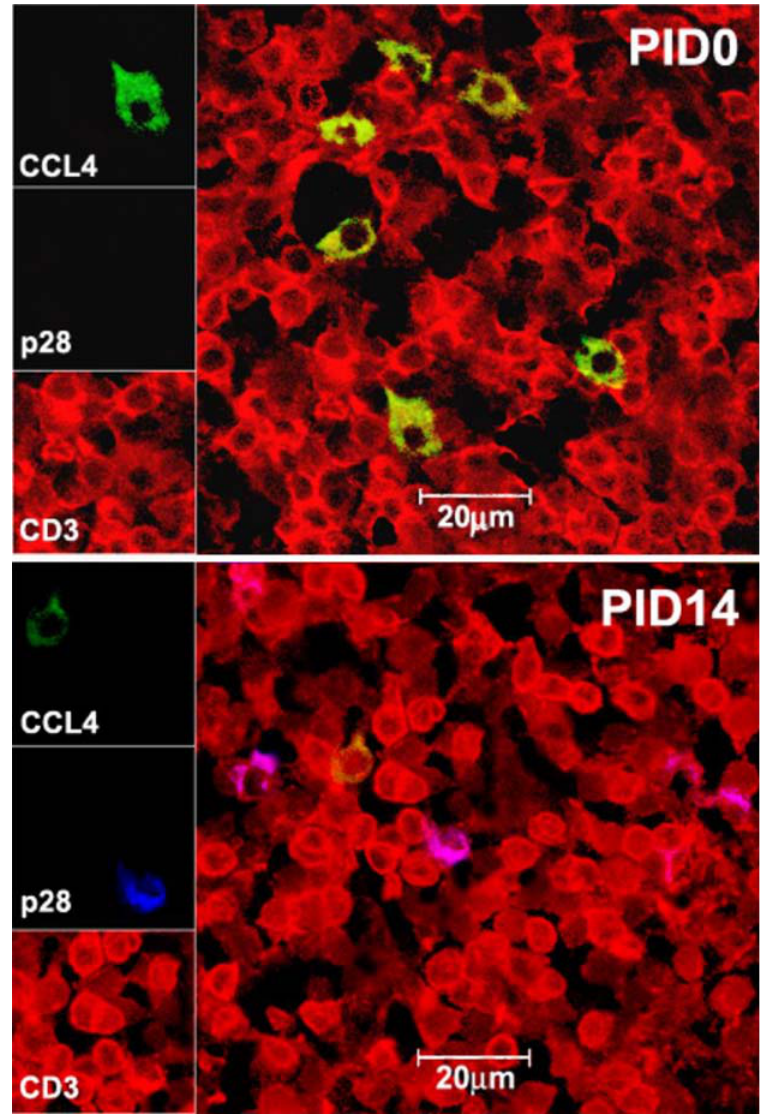
Figure 3. Triple-label confocal microscopy of CCL4 + cells in mesenteric lymph nodes obtained from control (PID 0) and SHIV SF162P4 -inoculated macaques at PID 14. T lymphocytes (CD3 + ) are red, CCL4 + cells are green, SHIV SF162P4 -infected cells (p28 + ) are blue. Overlap of red and green fluorescence is seen as yellow, overlap of red and blue as pink. Higher number of CD3 + CCL4 + cells was seen at PID 0 than at PID 14 (Table 1) while CD3 + p28 + cells could be seen at PID 14 but not at PID 0 indicating the successful spread of virus into GALTs following mucosal